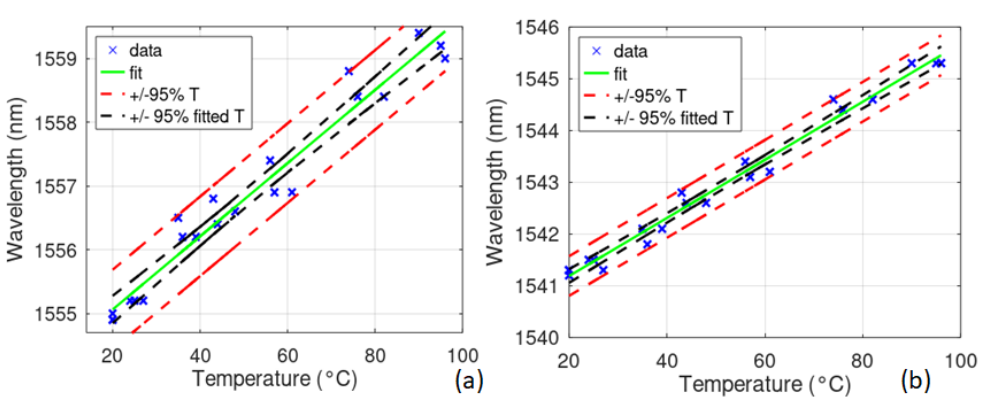
Figure 10. ( a ) Temperature response of the LP 03 mode of the LPFG as a function of thermal changes. ( b ) Temperature response of the LP 04 mode of the LPFG as a function of thermal